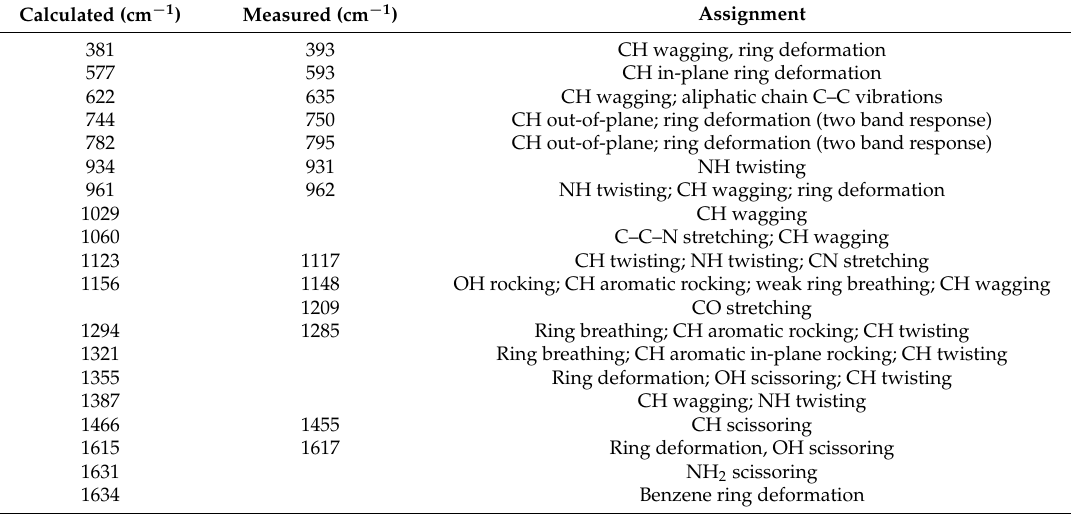
Figure 2. The redox process of dopamine consisting of the transfer of two electrons and two protons. The structural representations of neutral dopamine and dopaminequinone are also presented and appropriately labeled. Table 1. Theoretically calculated and experimentally measured Raman vibrations of dopamine with their tentative assignments.